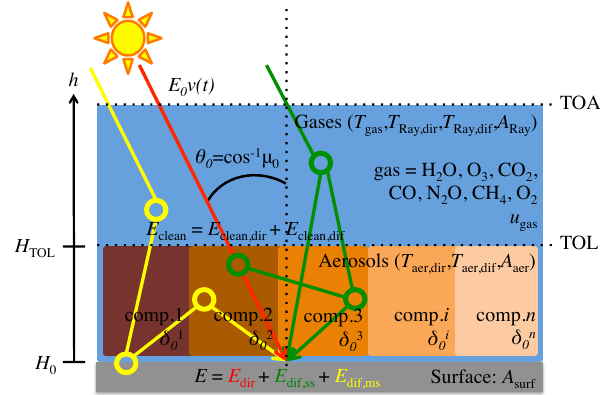
Figure 1. Scheme of the solar irradiance reaching the Earth’s sur- face or DSSF ( E ). Note that the use of separate blocks for each aerosol component (referred to as comp. i in the figure) is done for the sake of illustration, as the n species are mixed forming a homo- geneous aerosol layer. The description of each quantity in the figure may be found in the